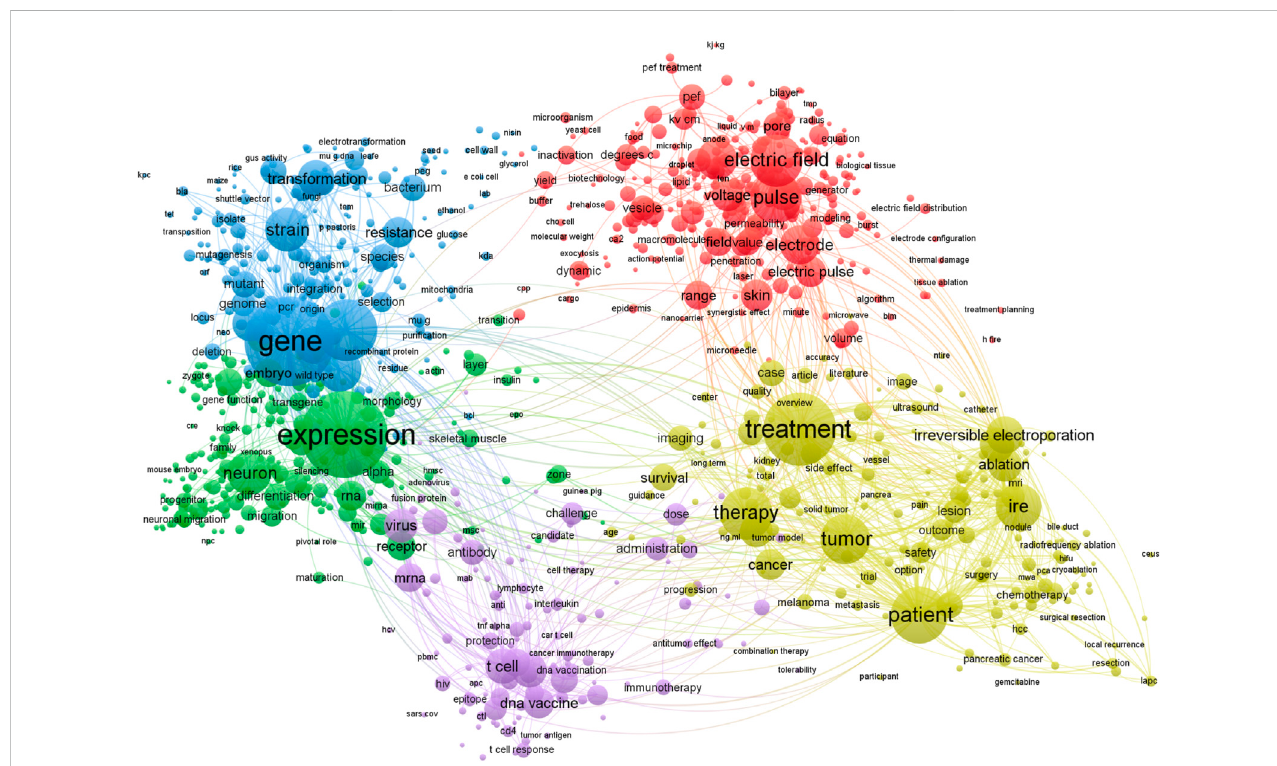
FIGURE 1 Most common keywords used in electroporation studies. Visualized using VOSviewer software, version 1.6.18 (Leiden University) (VOSviewer - Visualizing scienti fi c landscapes, 2022). A fi lter of at least 30 minimum occurrences of the keywords has been used. Bigger circle size indicates higher rate of occurrence of a speci fi c